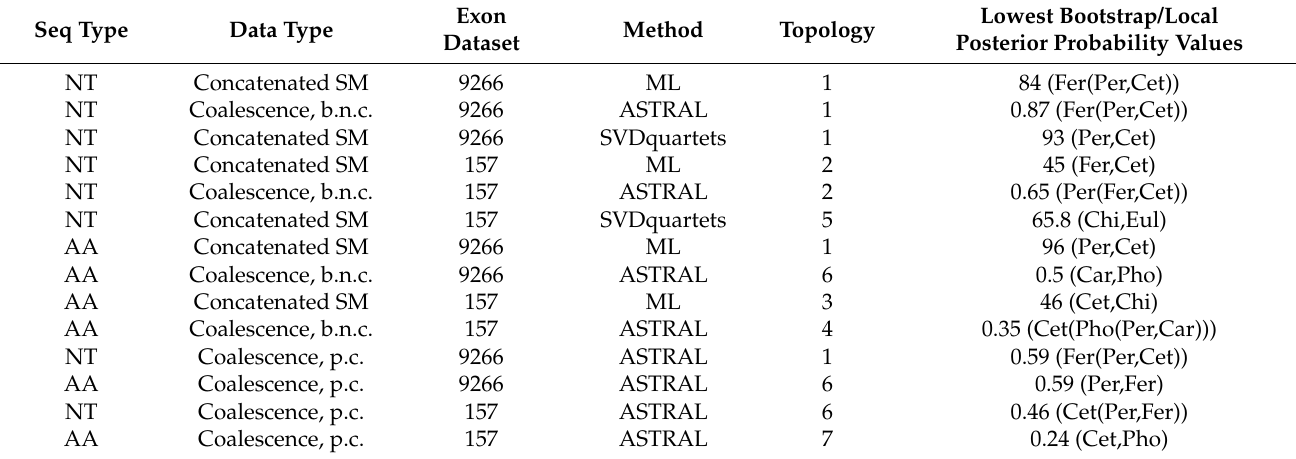
Table 1. Exon datasets and methods used to construct the laurasiatherian topology. Datasets both with (9266 exons) and without a minimum length of 500 bp (157 exons) are displayed. The interordinal clades within Laurasiatheria with the lowest bootstrap/posterior probability values are also displayed. NT denotes nucleotide, AA denotes amino acid, SM indicates supermatrix, p.c. indicates branches < 0.01 substitutions per site collapsed into polytomies, b.n.c.—branches not collapsed, ML